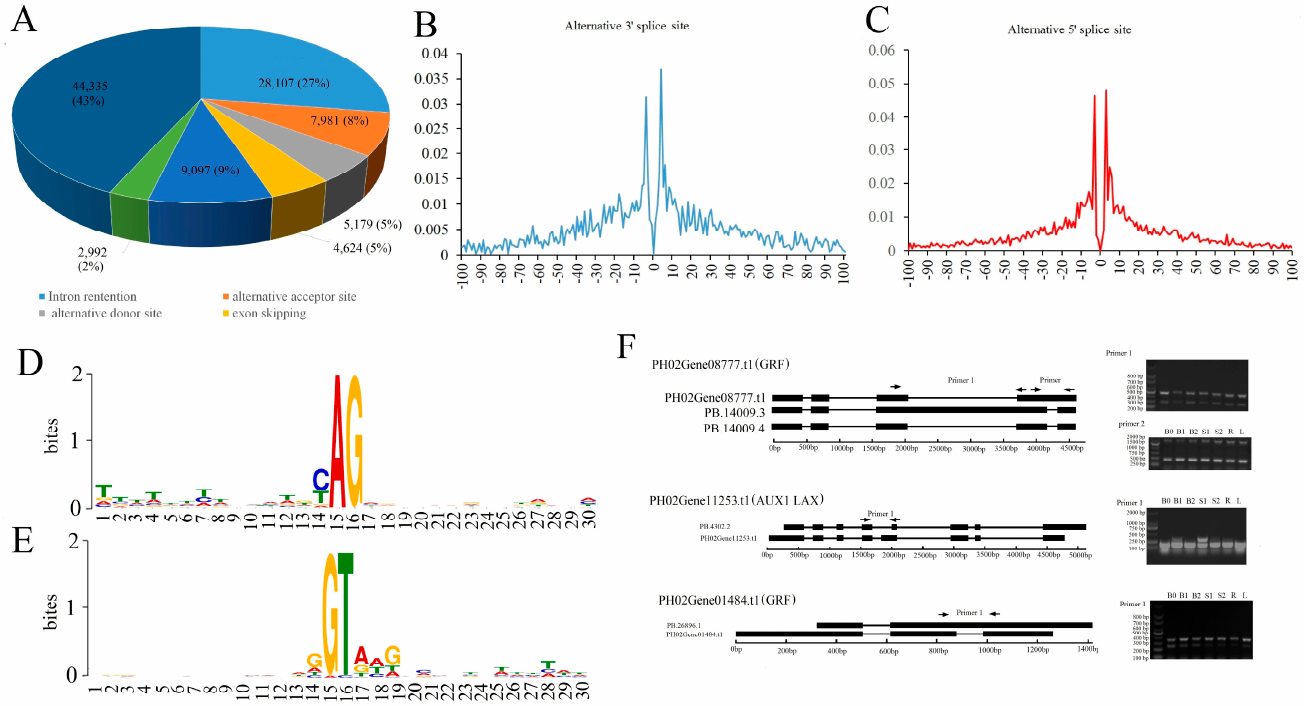
Figure 5. Characteristics of alternative splicing events in Moso bamboo growing culms. ( A ) Statistics of the different types of AS events in the Moso bamboo genome. ( B , C ) The distribution of the activated 5 ′ splicing sites ( B ) and the activated 3 ′ acceptor sites ( C ) around the dominant splice sites. ( D , E ) The nucleotide sequences around the alternative 5 ′ donor sites ( D ) and 3 ′ splicing sites ( E ). ( F ) PCR validation of six AS events identified by Iso ‐ Seq.